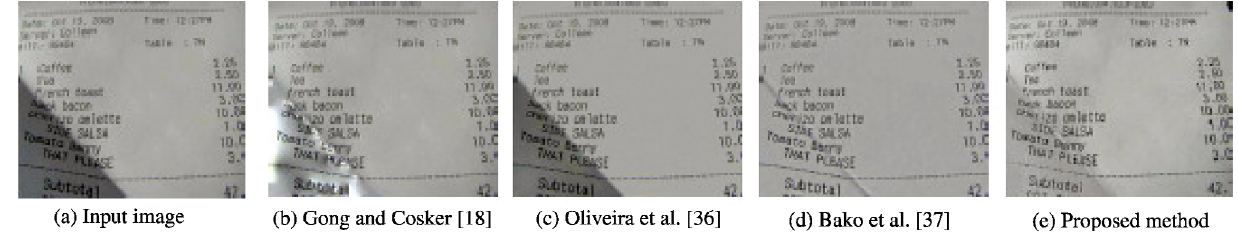
Fig. 7 Shadow removal from document images.